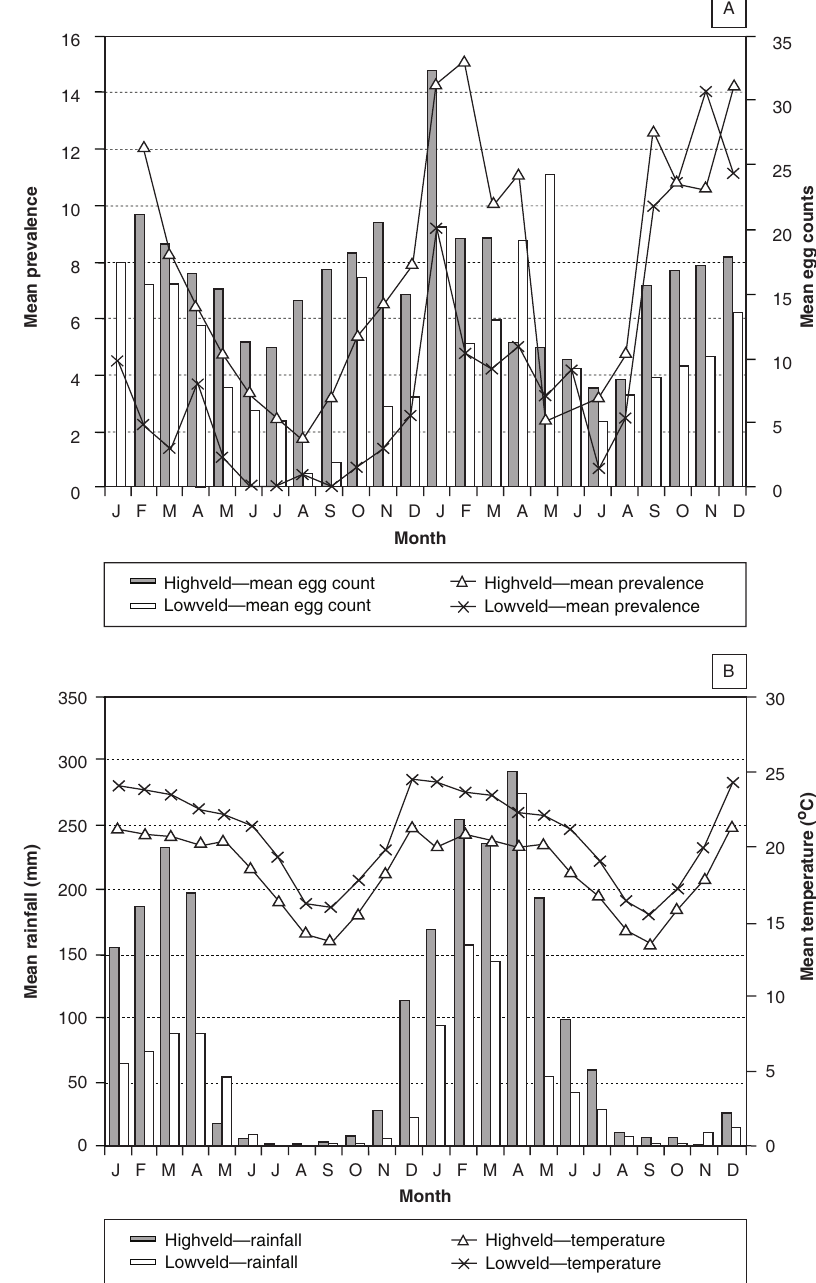
Snail abundance and distribution The relative abundances and distribution of snails according to region and district are shown in Table 4. A total of 2 936 B. globosus was collected during the entire period of the study, 2 222 from the high- veld (75.7 %) and 714 from the lowveld (24.3 %). A significantly higher mean number of snails was col- lected from the highveld than the lowveld ( P < 0.01). The mean number of B. globosus collected in Wedza 184